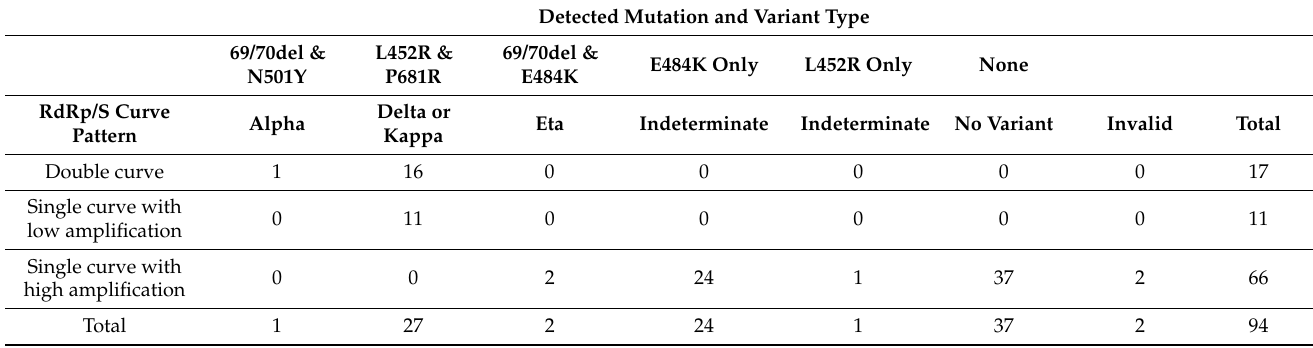
Table 1. RdRp/S curve pattern and variant types of SARS-CoV-2 positive clinical samples using Allplex SARS-CoV-2